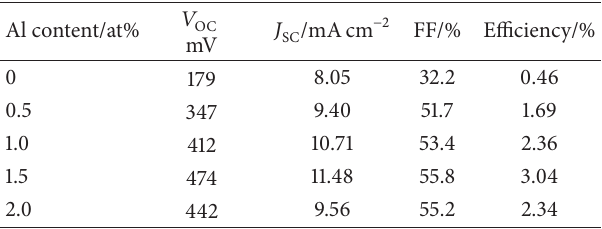
Table 1: Detailed photovoltaic parameters of the DSCs based on the SnO 2 hollow microspheres doped with different Al content.